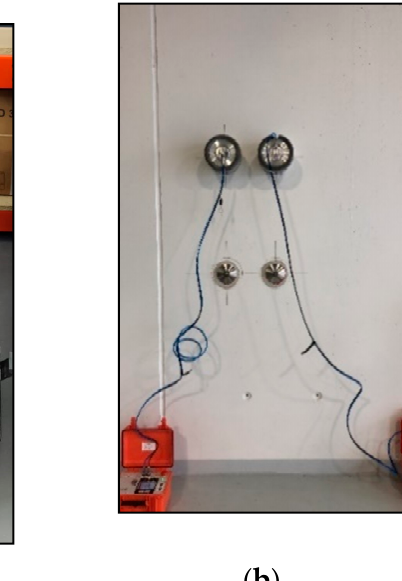
Figure 3. ( a ) Tooling for the installation of C-BLOCK fastener; ( b ) on-going installation cycle. Concrete slabs dimensions were 1440 mm × 500 mm × 330 mm. Four longitudinal